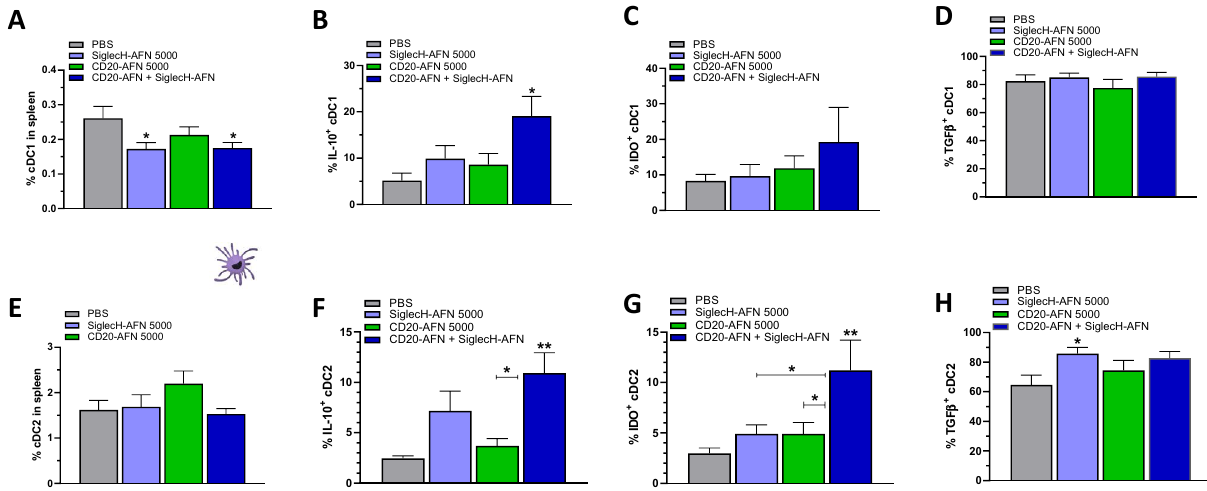
Figure 6. Superior protective combination therapy correlates with IL-10 and IDO expression in conventional dendritic cells. Numbers of splenic cDC1 decreased if EAE mice were treated with SiglecH-AFN ( A ), IL-10 expression was significantly enhanced only in case of combination therapy ( B ), and there were no significant changes in IDO or TGFβ expression ( C , D ). Numbers of cDC2 in EAE mice were not affected by AFN therapy with ( E ), IL-10 and IDO expression were significantly enhanced only in case of combination therapy ( F , G ), TGFβ expression by SiglecH-AFN only ( H ). Shown are 2 pooled experiments (n = 7). Differences were assessed using one-way ANOVA followed by Tukey’s multiple-comparison test; *P < 0.05, **P < 0.01, compared with PBS treated animals, unless otherwise